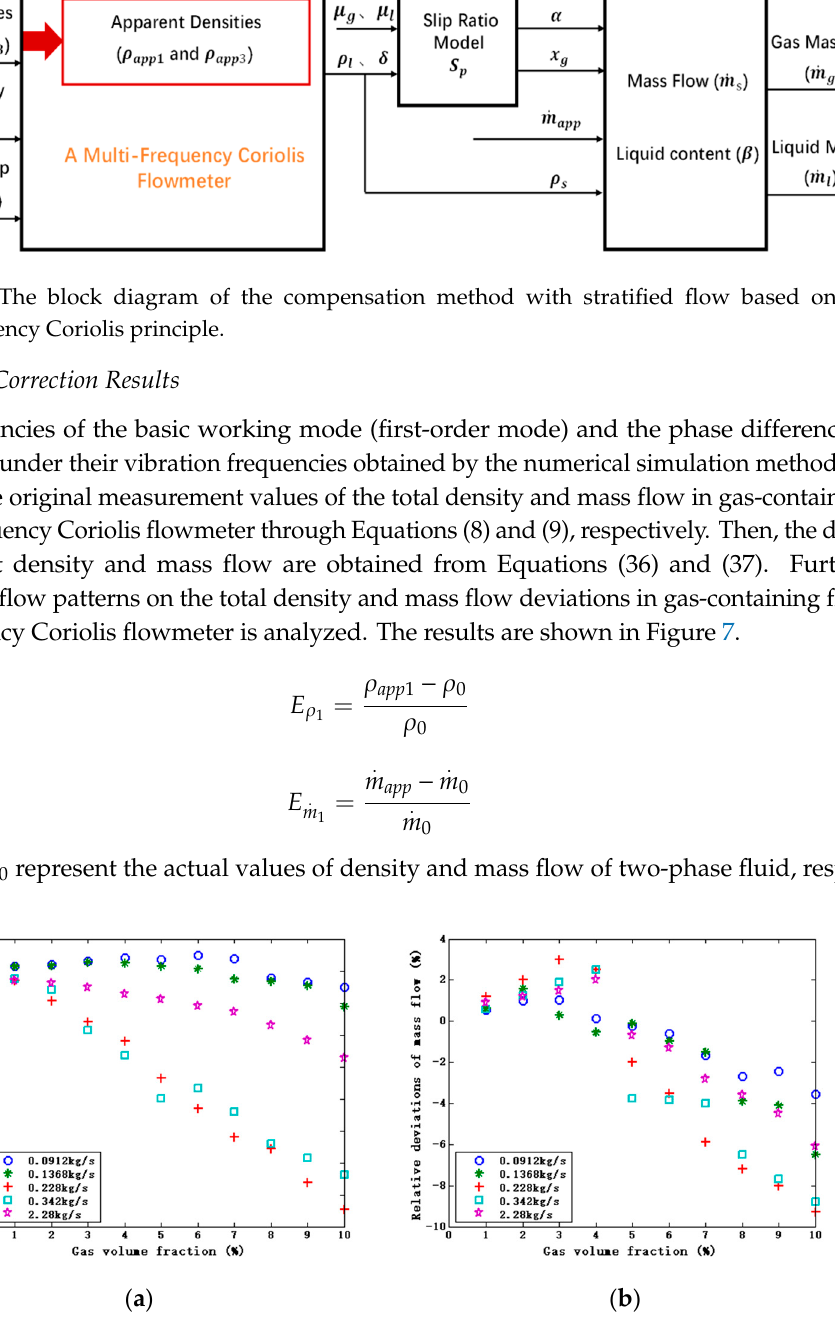
Figure 8. The deviations relative to GVF after correction by the proposed compensation model. ( a ) Relative deviations of density. ( b ) Relative deviations of mass flow. Taking the two vibration frequencies of the measuring tube, and apparent densities of the measured fluid as the input parameters, the calculated gas and liquid contents can be converted to the gas-phase and liquid-phase mass flows in the stratified flow. The corrected relative deviations in the gas-liquid two-phase flow are obtained from Equations (42) and (43), respectively. The calculation results are shown in Figure 9.